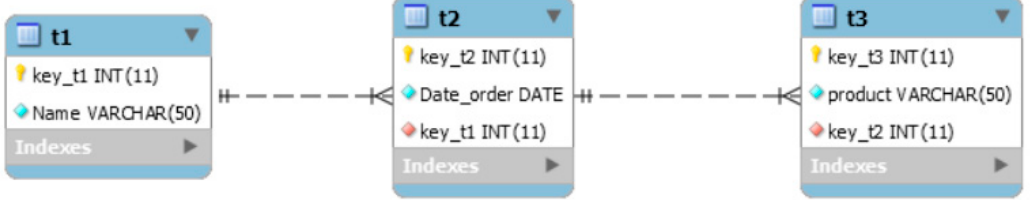
Figure 7. A diagram showing the execution time of eight queries to a database of two types: a single database and a database with embedded documents.